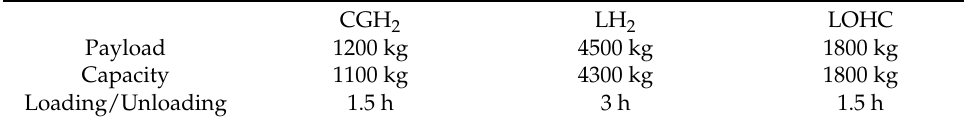
Table 3. Trailer assumptions based on Reuss et al.